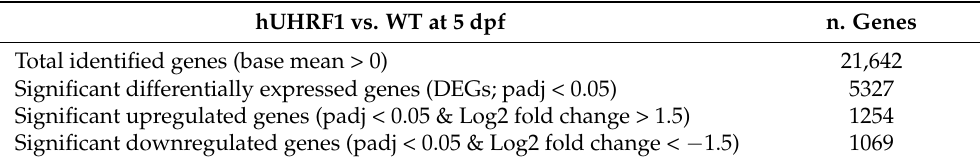
Table 1. Differentially expressed genes in 5 dpf zebrafish livers with hUHRF1 overexpression in hepatocytes based on bulk RNA-seq